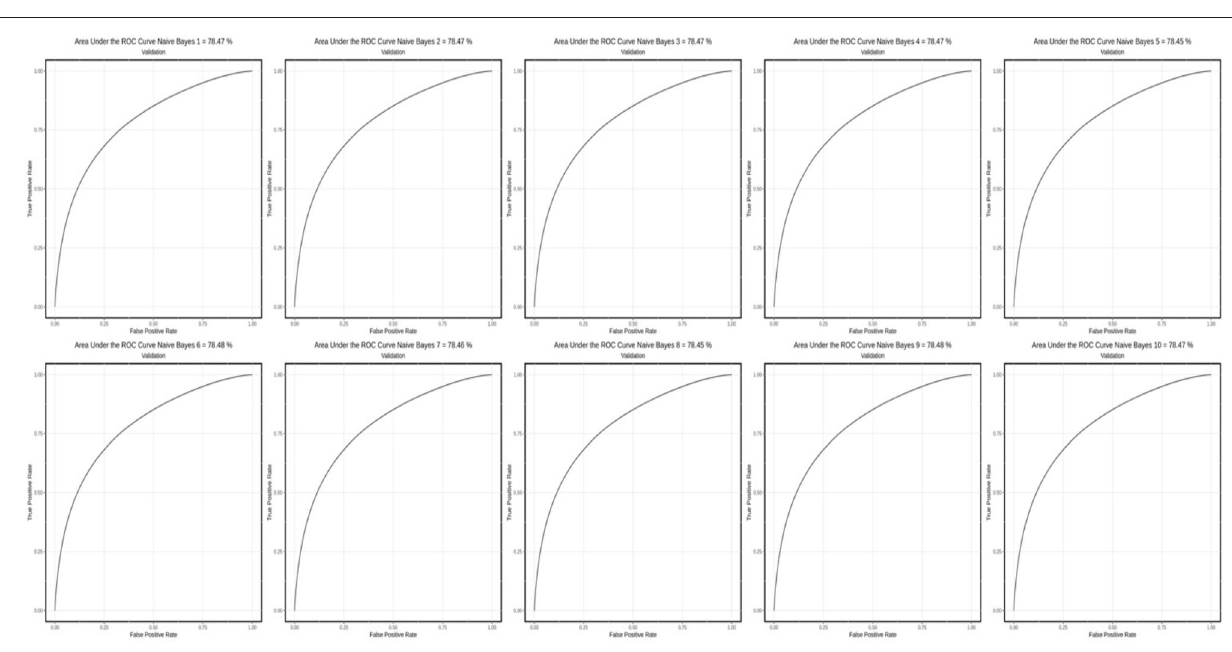
new dataset resulting from the SMOTE technique with 300% was used to build a classification model and prediction of obesity risk